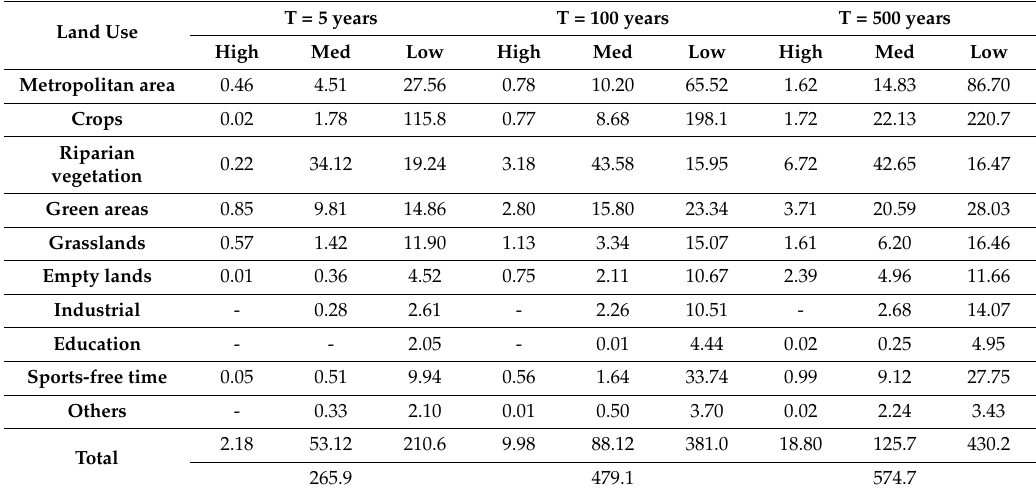
Table 5. Land use and extension (Ha) of flood zones in each scenario.